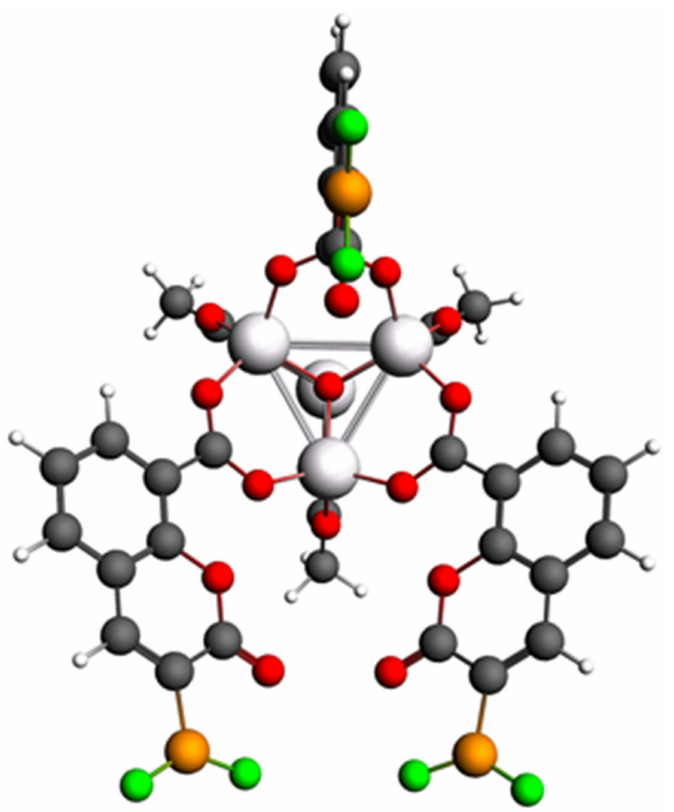
Figure 2. Structure of the primitive cell of IRMOF-C-BF 2 , after the proper filling with CH 3 and H groups for OCO bridges and C5 position of the coumarin ring, respectively. Coordinates in xyz format available in the Supplementary